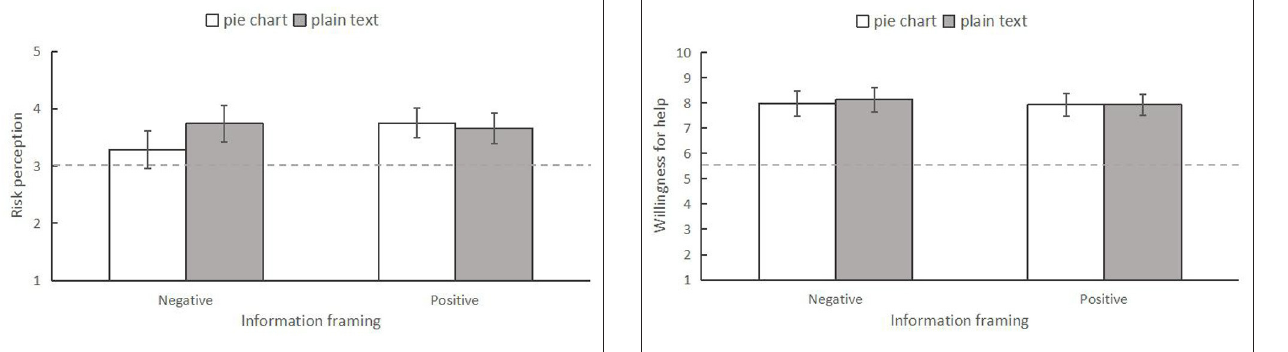
FIGURE 8 | The interaction between information frame and information form on willingness to help in Experiment 2. The error bars indicated 95%